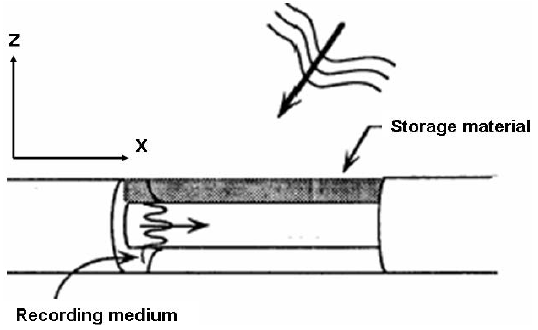
Figure 2. Recording of an evanescent wave hologram in the microtubule